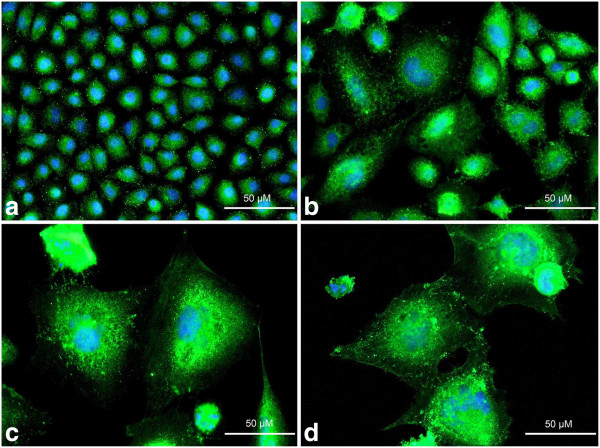
a-d Localization of G-actin in A549 cells after treatment with etoposide - fluorescence microscopic examination (labeling with VDBP). a Control cells, b 0.75 μM etoposide, c 1.5 μM etoposide, d 3 μM etoposide. Visible aggregation of G-actin in the perinuclear area after the treatment, as well as in the form of dot-like structures in the cytoplasm. The intense fluorescence patterns indicative of cells with DNA fragmentation. Nuclei were counterstained with DAPI. Results are indicative of five independent experiments. Bar 50 μm.